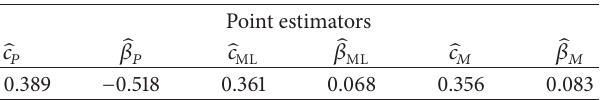
Table 4: Estimates of the parameters of the discrete Weibull for the first example